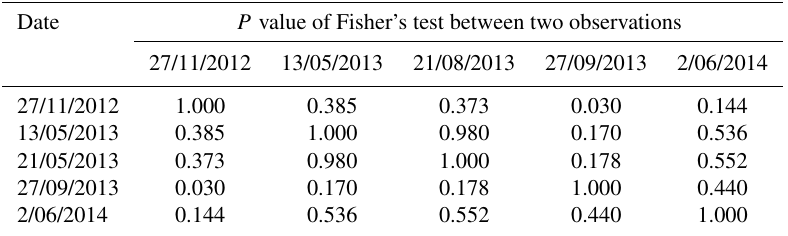
Table 5. P values of the Fisher’s test applied to check if variances of input data are the same in each pair of the UAV observations. Date P value of Fisher’s test between two